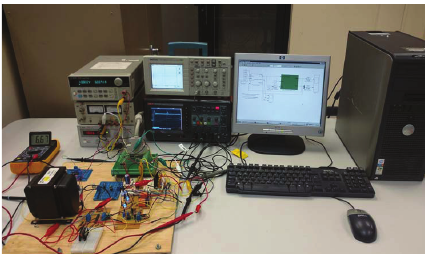
Figure 5: Experimental platform equipped with measurement circuits for output voltage and inductor current, circuit for online modification of the input voltage 𝐸(𝑡) , PWM circuit, and boost converter with replaceable capacitor, inductor, and